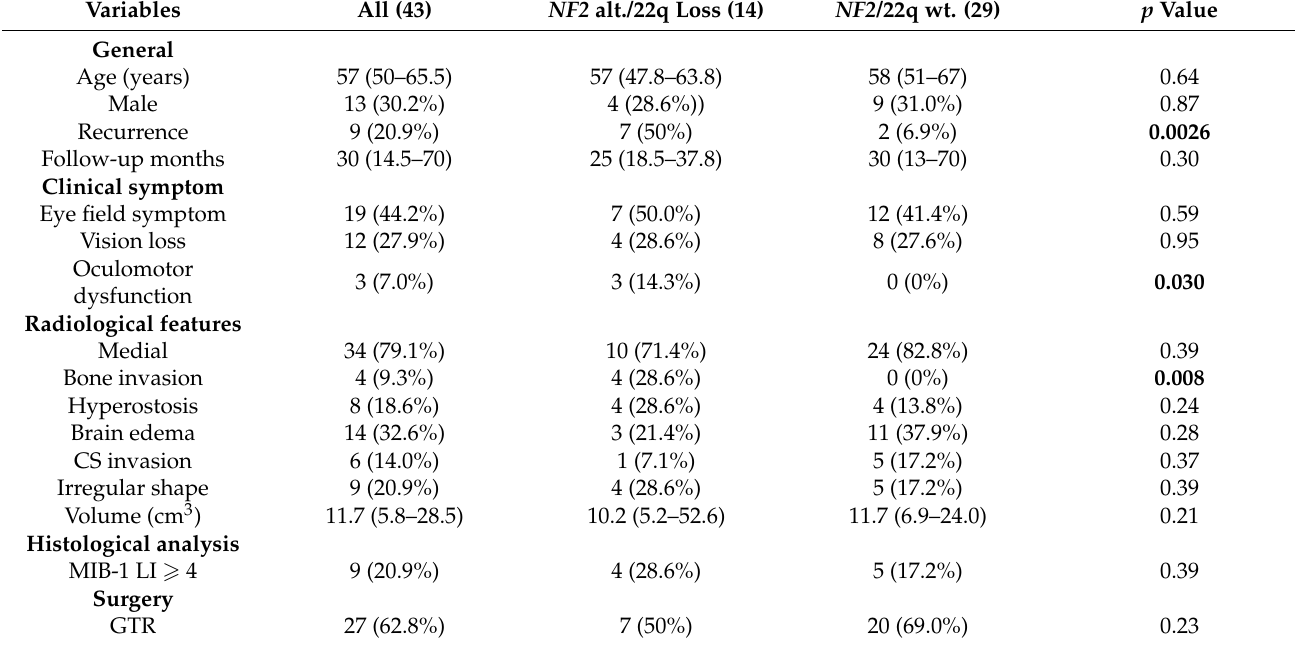
Table 2. Characteristics of patients with WHO grade 1